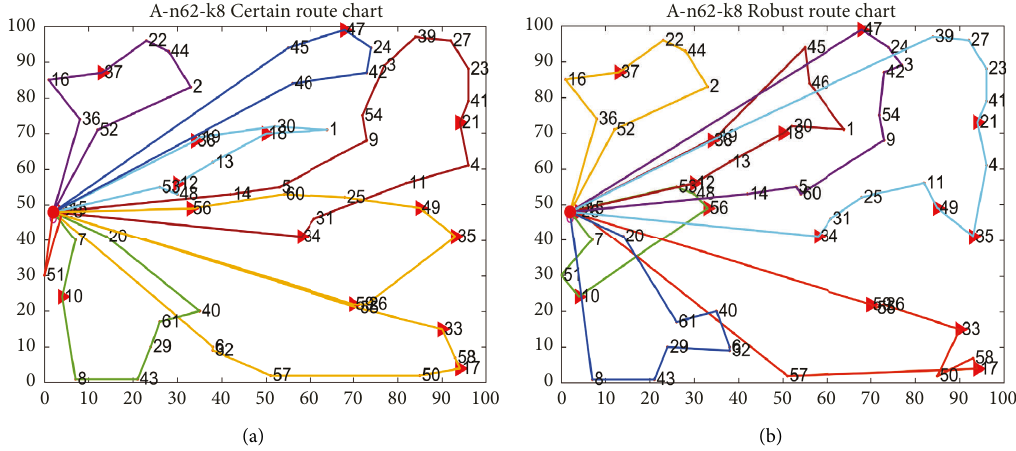
Figure 5: A-n62-k8 certain (a) and robust (b) route comparison